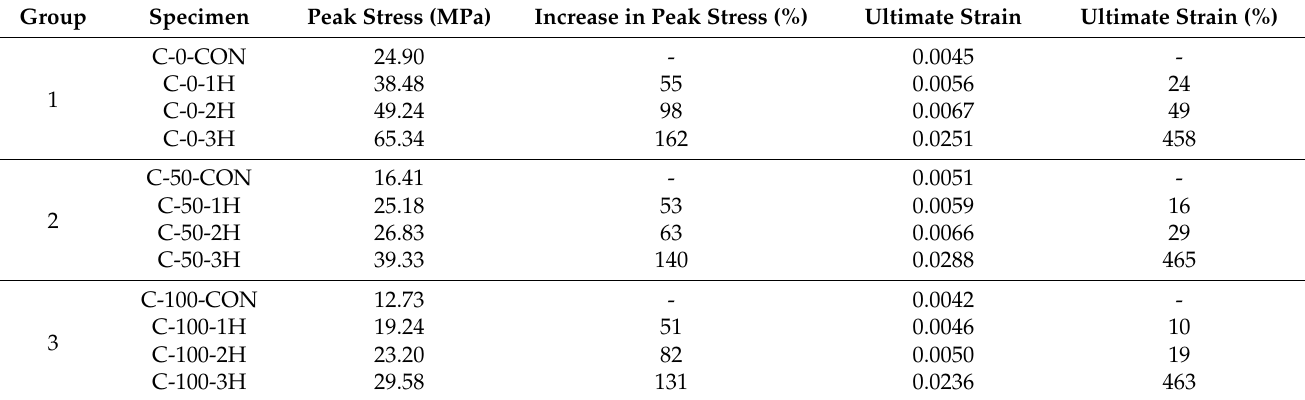
Table 3. Summary of peak compressive stress and corresponding